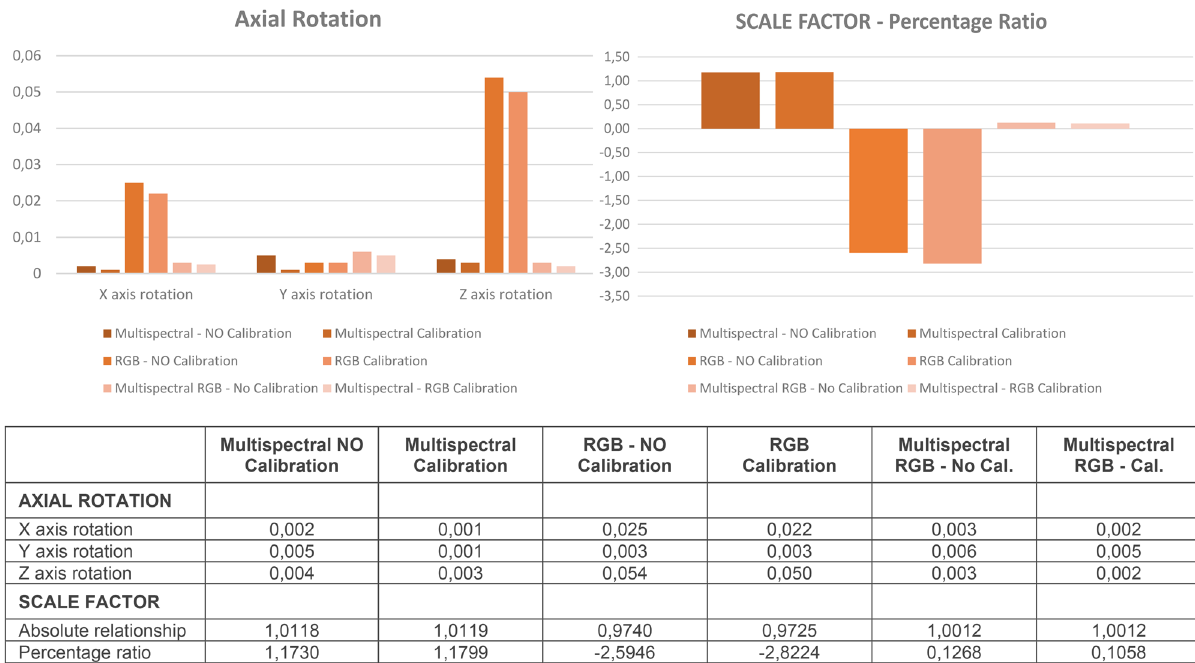
• multispectral-RGB: photos captured with the DJI®